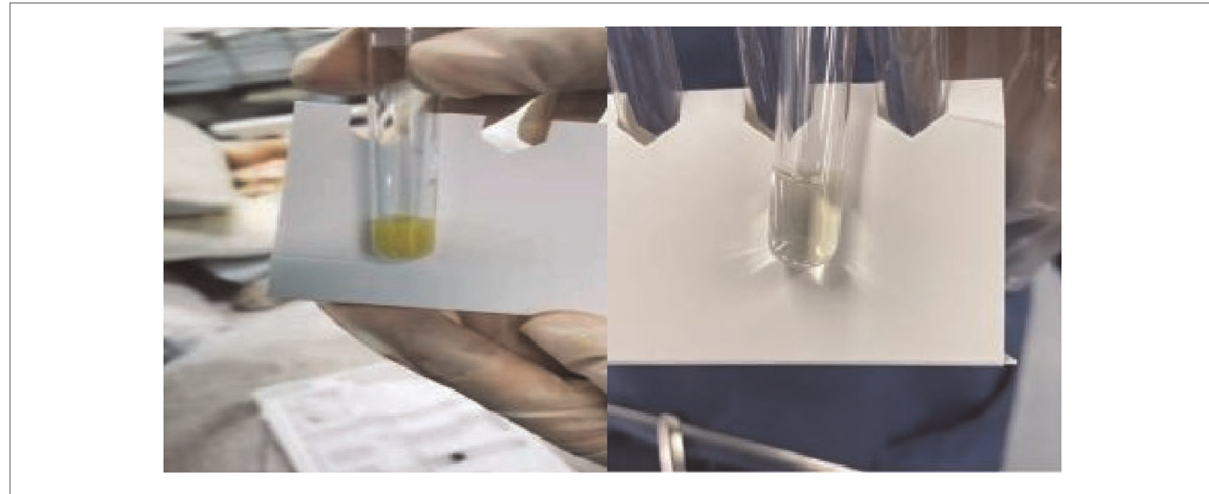
FIGURE 2 Cerebrospinal fl uid (CSF) before treatment and after